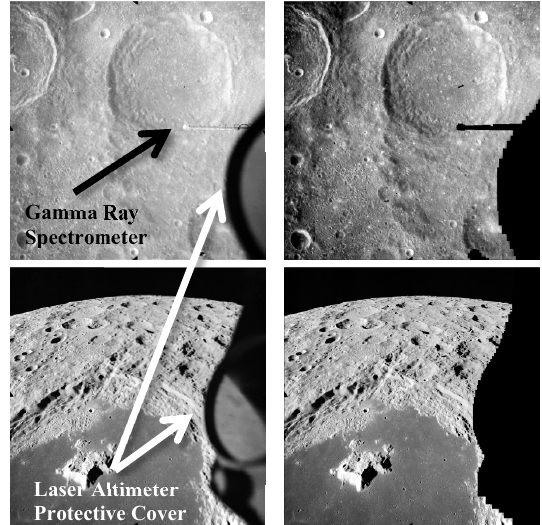
Figure 7: Hardware artifacts and blemishes before and after masking. Top: AS15-M-2095. Left – MC was not fully extended, leaving part of the Laser Altimeter protective cover in view. The Gamma Ray Spectrometer is also visible. Right – hardware is masked. Bottom: AS15-M-1442. Left – Laser Altimeter protective cover in view. Right – hardware masked. Images courtesy NASA/JSC/ASU.